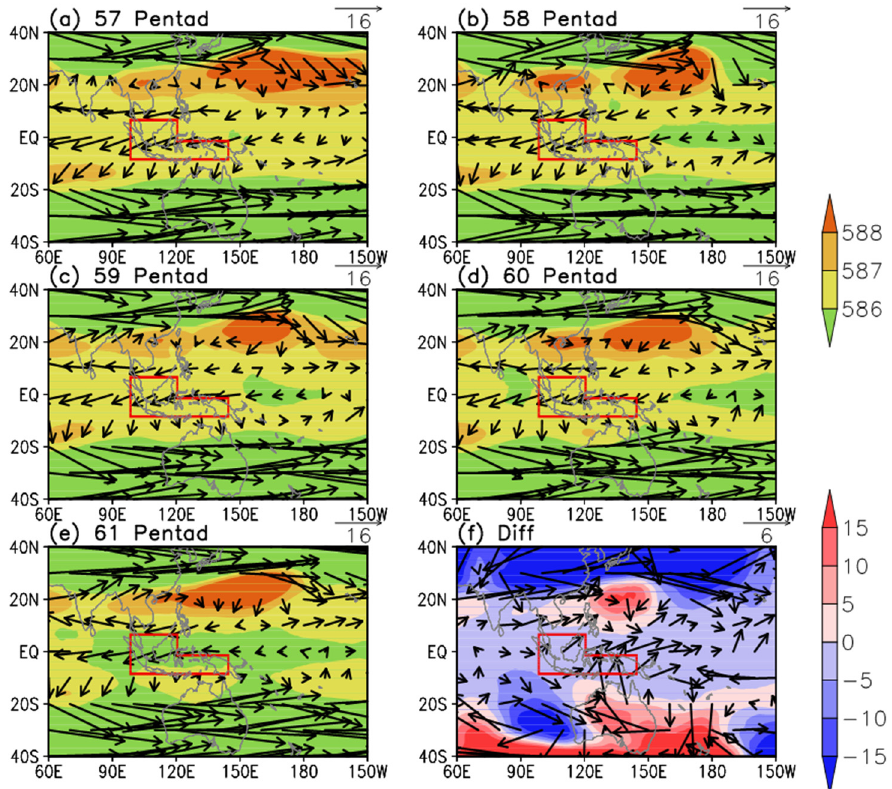
Figure 6. Climatological-mean 500-hPa geopotential height (CFSR; dgpm; shading) and 200-hPa winds (CFSR; m/s; vectors) for ( a ) 57th pentad; ( b ) 58th pentad; ( c ) 59th pentad; ( d ) 60th pentad; and ( e ) 61st pentad; ( f ) Differences between 60th–61st pentad mean and 57th–58th pentad mean. The domain of the Maritime Continent is outlined with red boxes.